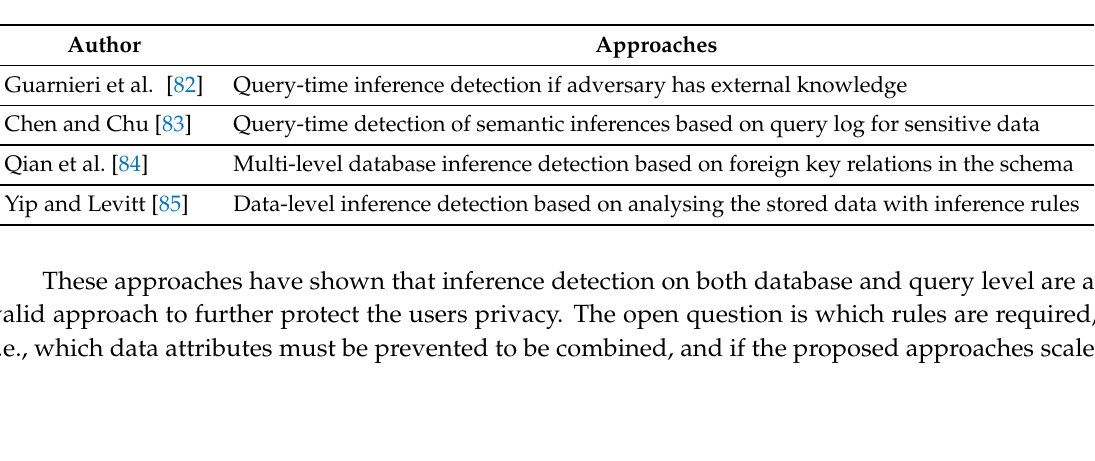
Table 5. Overview of selected approaches for inference detection for privacy-preservation at query-time, database-level and data-level from the